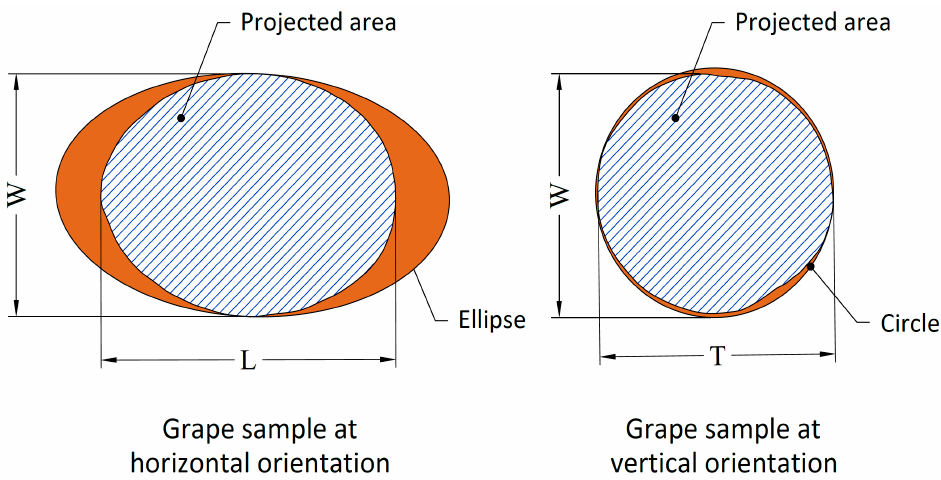
Figure 3. Size and area measurements of the grape varieties.